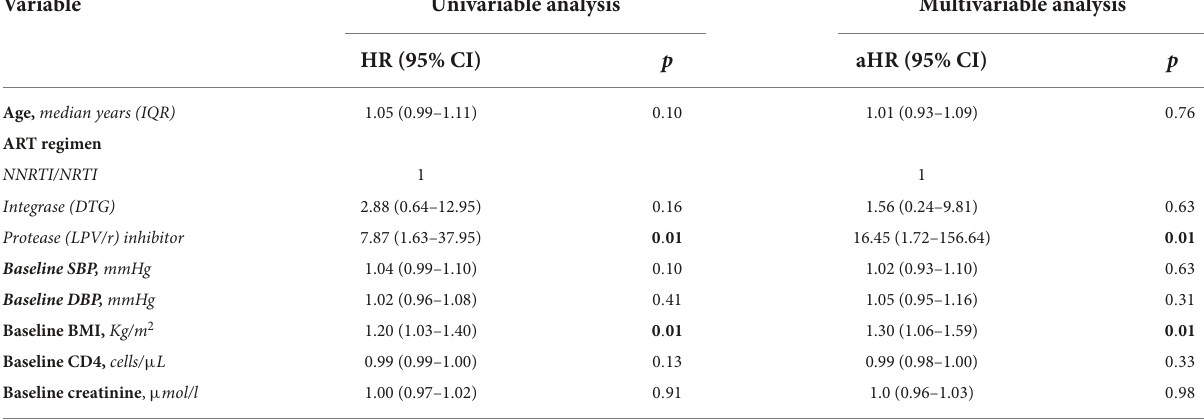
TABLE 5 Predictors of incident hypertension in males with HIV. Variable Univariable